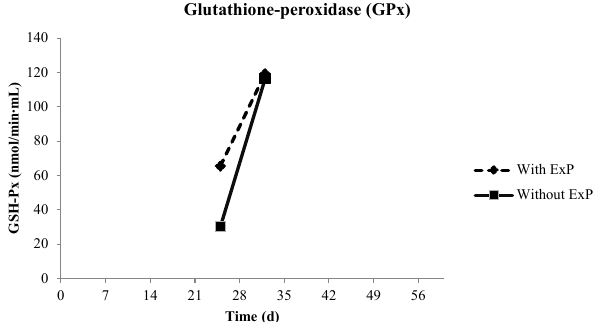
Figure 2. Higher superoxide dismutase activity in plasma of in Dorper×Santa Ines lambs receiving a high-concentrate diet with different antioxidant additives at d 32.